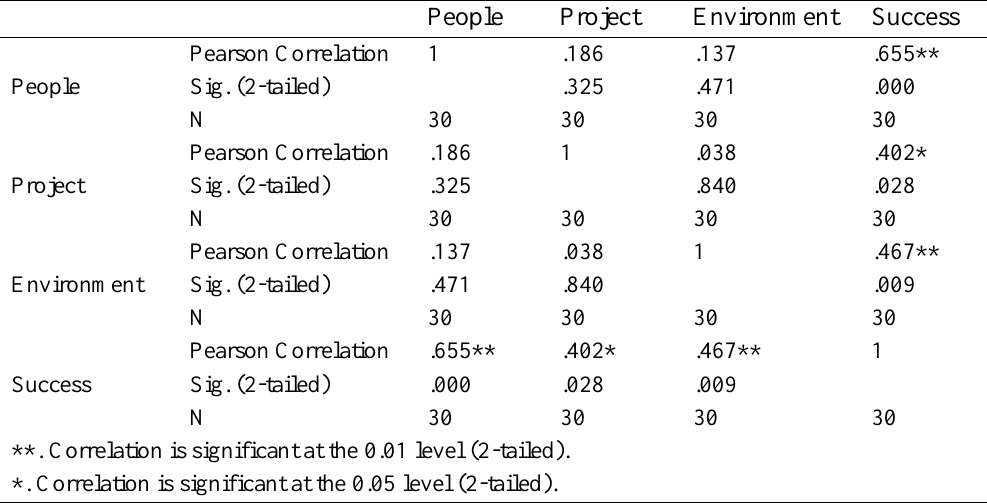
Table 2. Correlations between Variables.